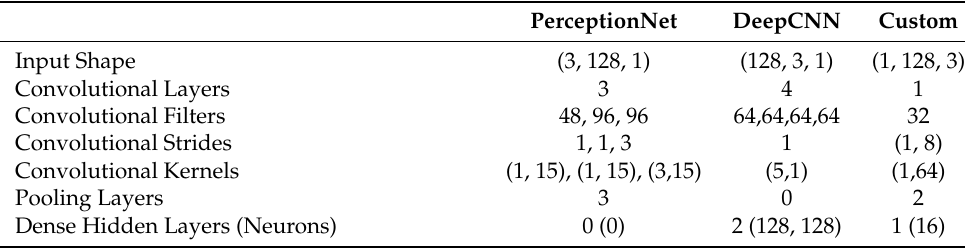
Table 2. A comparison of the three neural network architecture main features. PerceptionNet DeepCNN Custom Input Shape (3, 128, 1) (128, 3, 1) (1, 128, 3) Convolutional Layers 3 Convolutional Filters 48, 96, 96 Convolutional